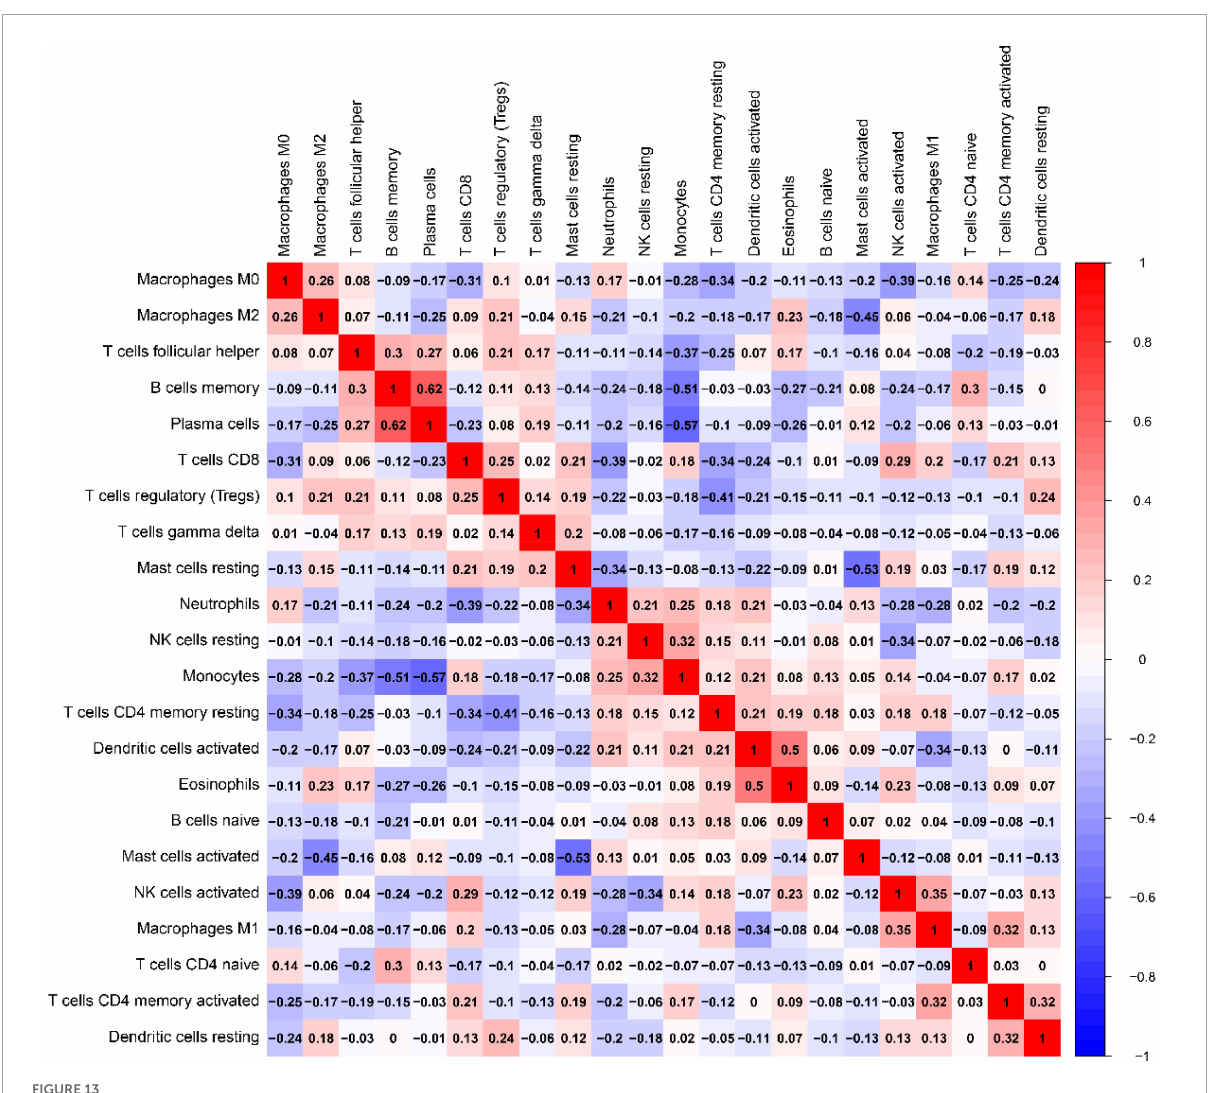
FIGURE13 Relevance matrix of components of all 22 immunocyte subtypes. Both the horizontal and Vertical axis show immunocyte subtypes. Immunocyte subtype composition (higher, lower, and the same correlated levels are shown in red, blue, and white,